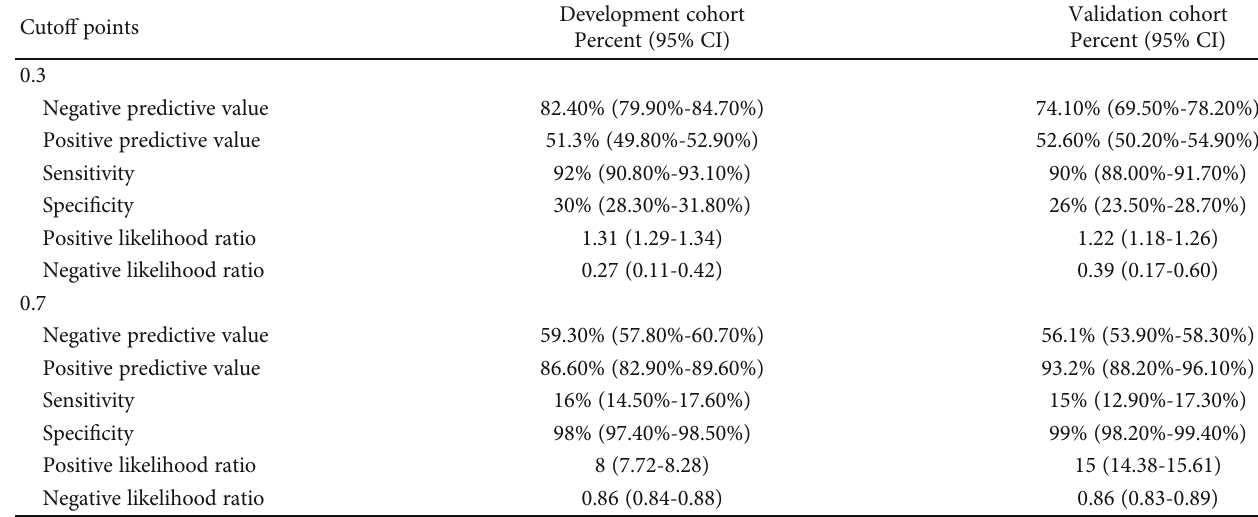
Table 2: Performance of the cuto ff points of 0.3 and 0.7 for the GBDT model in predicting GDM.